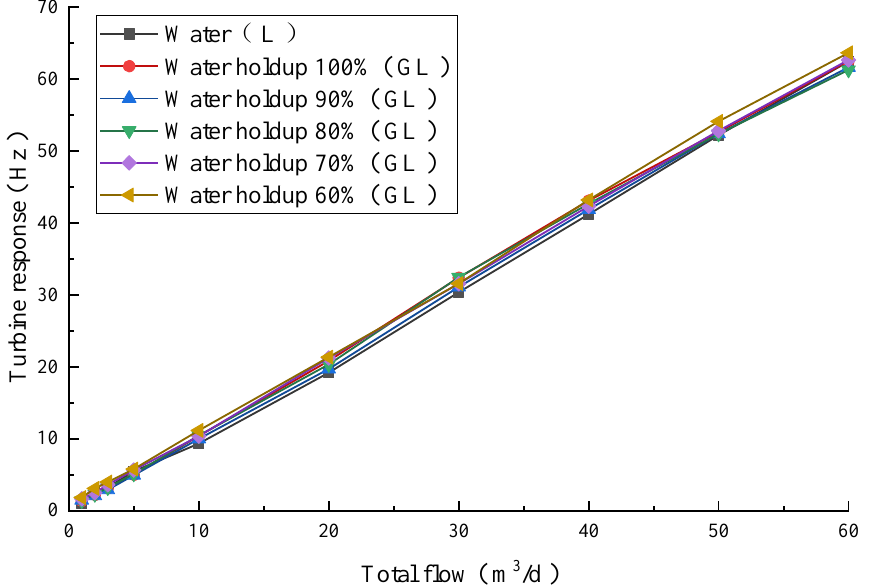
Figure 14. Response curve of the turbine flowmeter with different total liquid flow when gas flow rate is 5 m 3 /d.